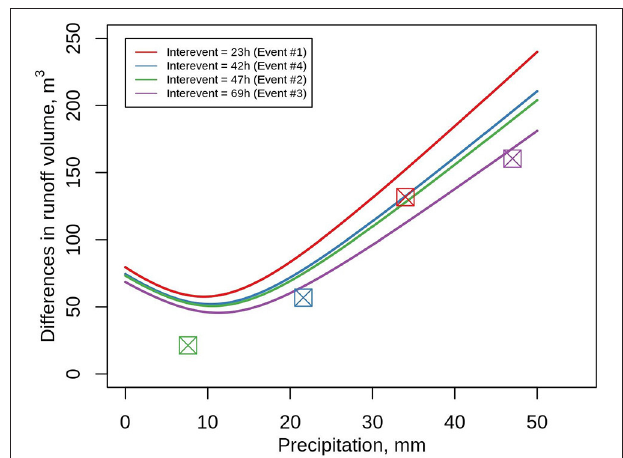
FIGURE 7 | Differences in runoff volume required to overcome noise in monitoring data, given depth of rainfall event and interevent period (colored lines) compared to runoff volume differences between two scenarios for each event (colored boxes). Colored Boxes represent differences in runoff volume simulated between two most different micro land use scenarios in this study: IS_MAX and GI_ROW. None of the colored boxes exceed the predicted magnitude of noise associated with that